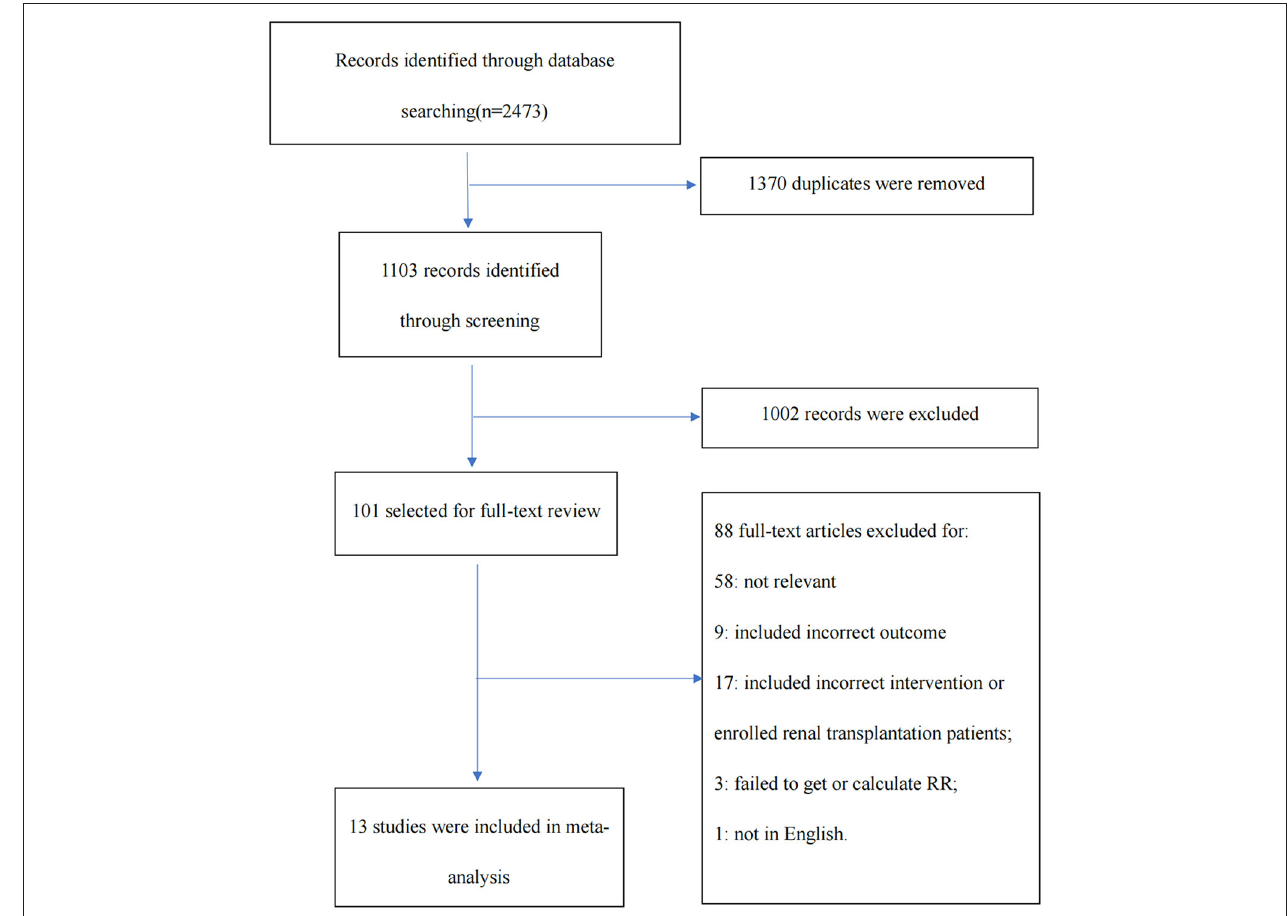
FIGURE 1 | The Preferred Reporting Items for Systematic Reviews and Meta-Analyses (PRISMA) diagram illustrating the study selection